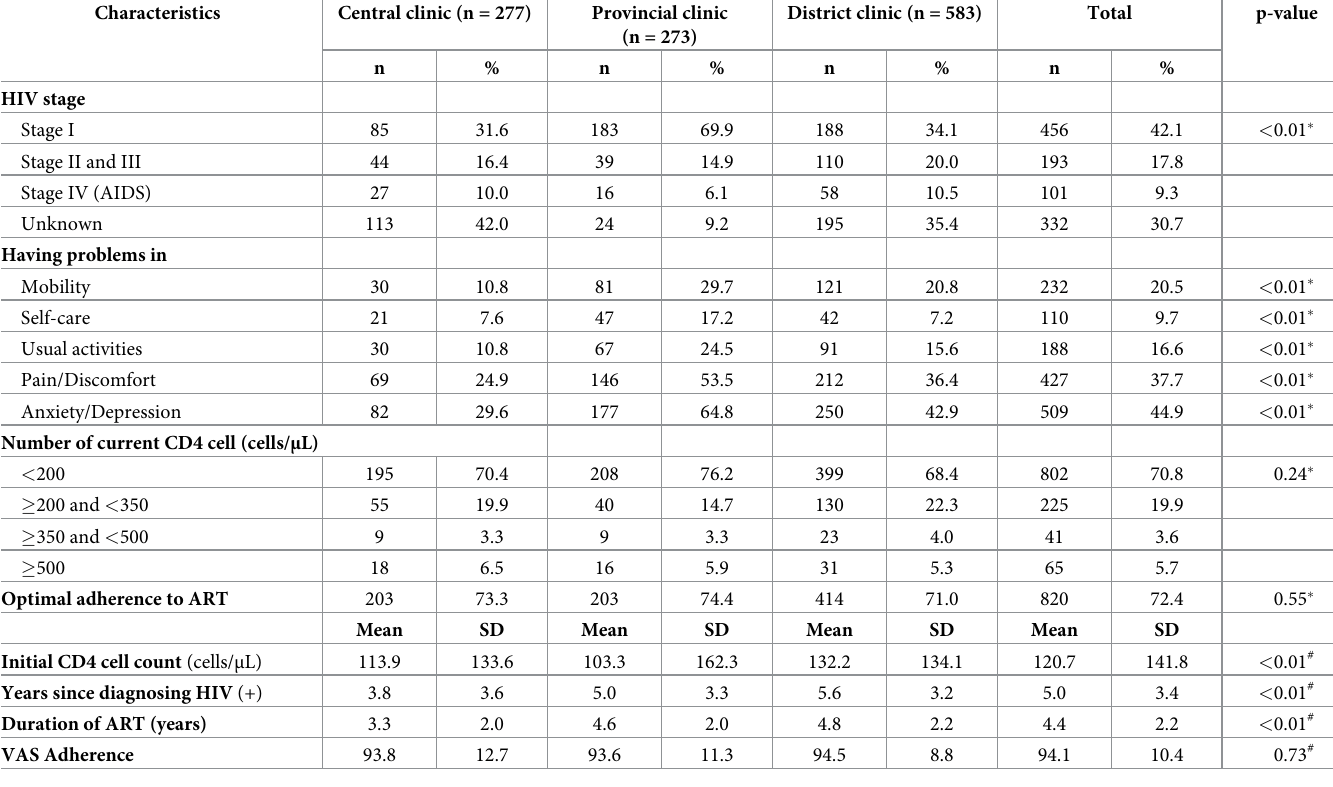
Table 2. Clinical characteristics and treatment outcomes among respondents (n =